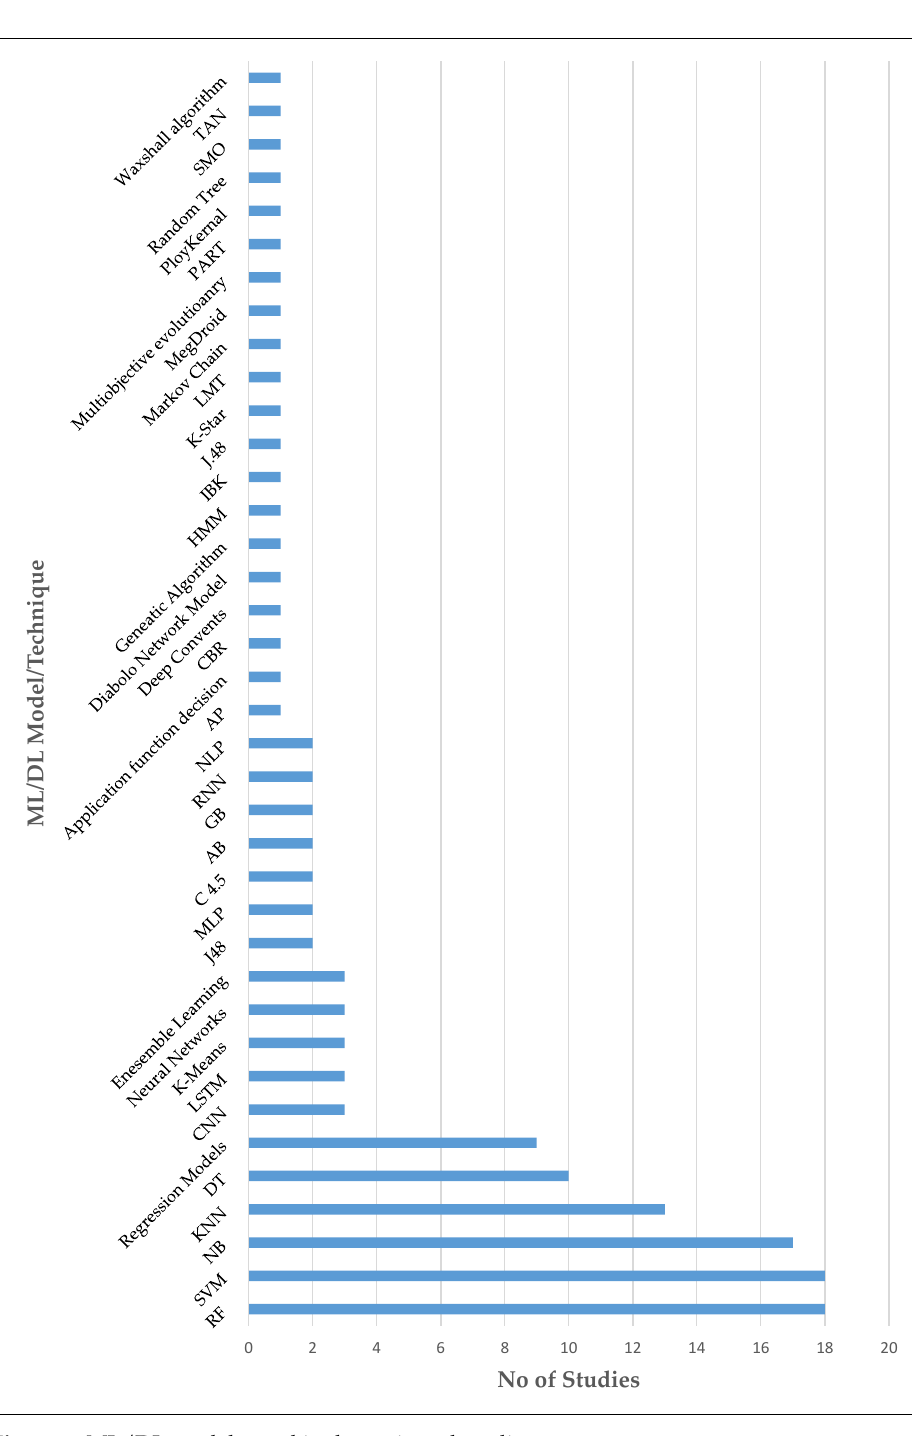
Figure 7. ML/DL models used in the reviewed